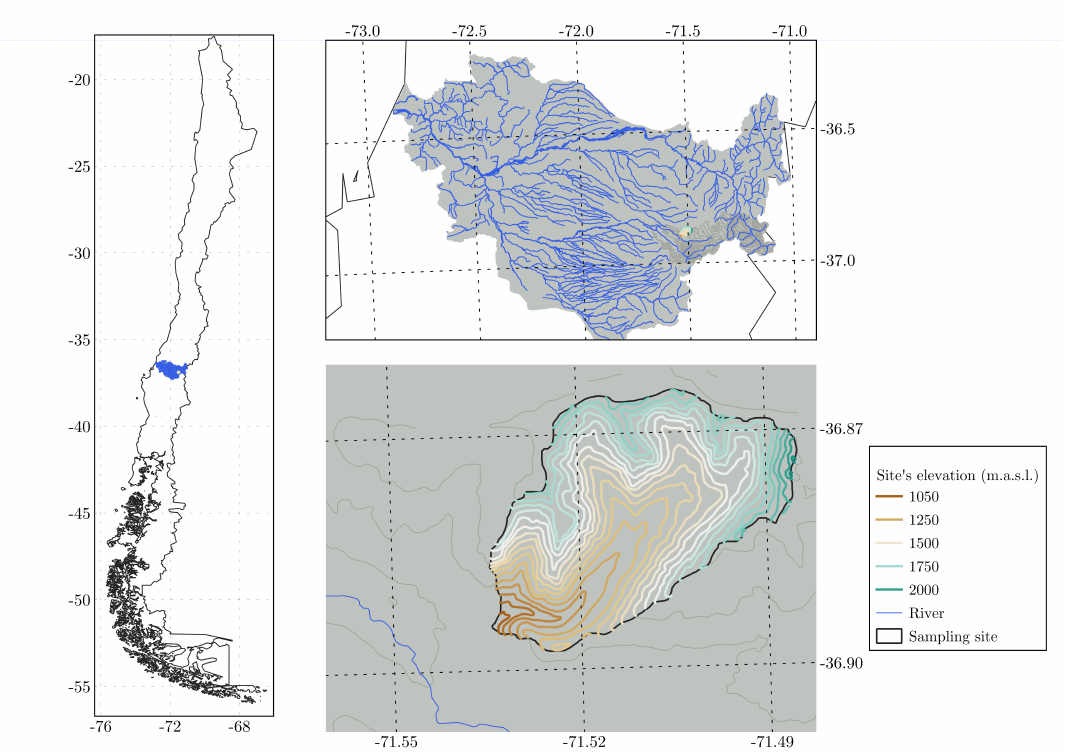
Figure 1. Location of the study